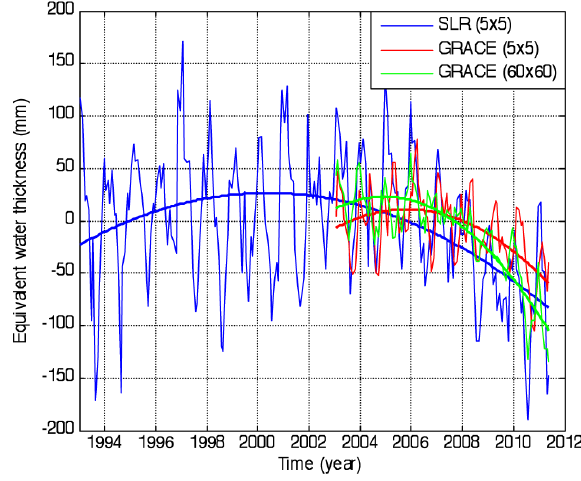
Figure 2. Time series of ice-sheets mass variations in (74.5°S, 144.5°W) from SLR 5×5, GRACE 5×5 and GRACE